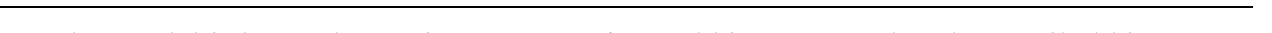
Fig. 6 Application to chick forebrain morphogenesis from SS5 to SS10. a , d Estimated deformation maps and spatial patterns of local deformation characteristics from SS5 to SS8 for one embryo a or from SS8 to SS10 for a different embryo d ; the fi gures show deformation of the dorsal apical surface (see Supplementary Figs. 9 – 11 for results on the deformation of the ventral apical surface, and the results for other embryos). No clear bias in the area growth rate was observed even with slight variations among positions. However, the deformation anisotropy was uniformly high throughout the entire forebrain and its direction was aligned along the medio-lateral axis (shown as black line segments on the surface). These tendencies were consistent from SS5 to SS10 (and still held until SS13, shown in Fig. 7). b , e Trajectory data from small aggregates of Q-rods (ranging 1 – 20 micrometers in diameter) attached to the apical surface that were used to infer the tissue deformation map. c , f The precision of the estimated maps was evaluated by prediction errors. The mean prediction error was on the order of a few cell diameters (on the apical surface). The yellow and blue dots indicate results for the u 1 and u 2 coordinates,